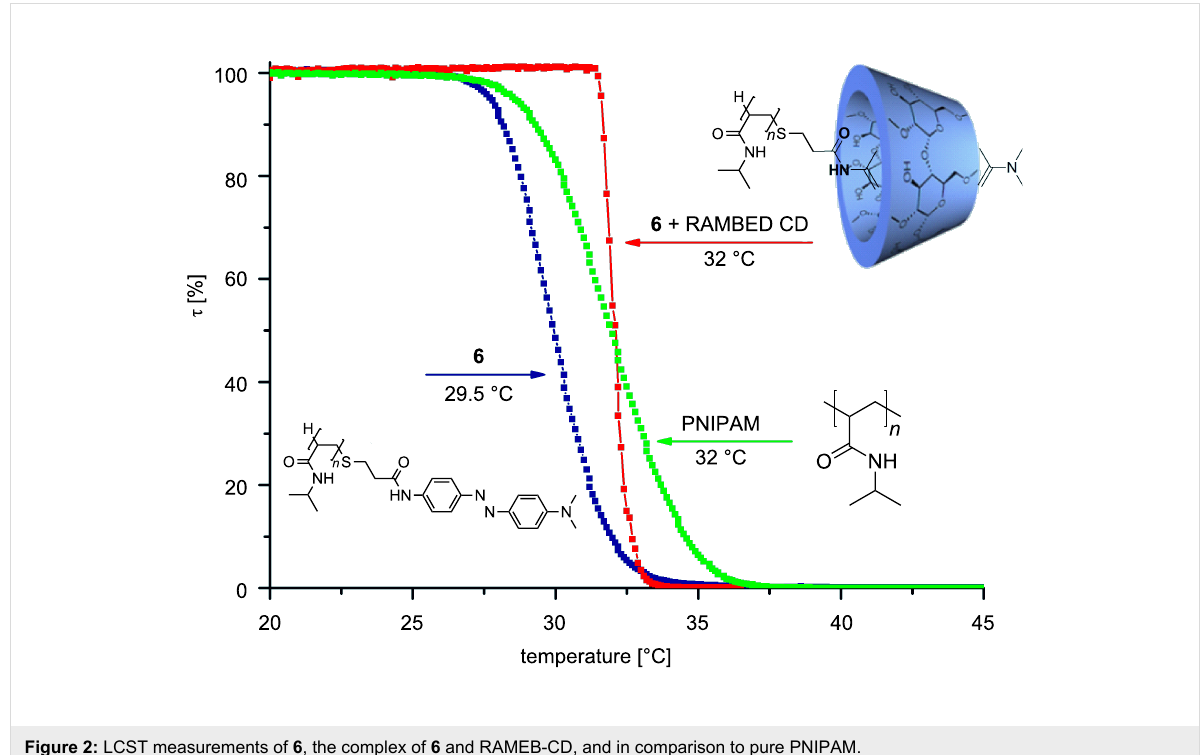
Figure 2: LCST measurements of 6 , the complex of 6 and RAMEB-CD, and in comparison to pure PNIPAM.